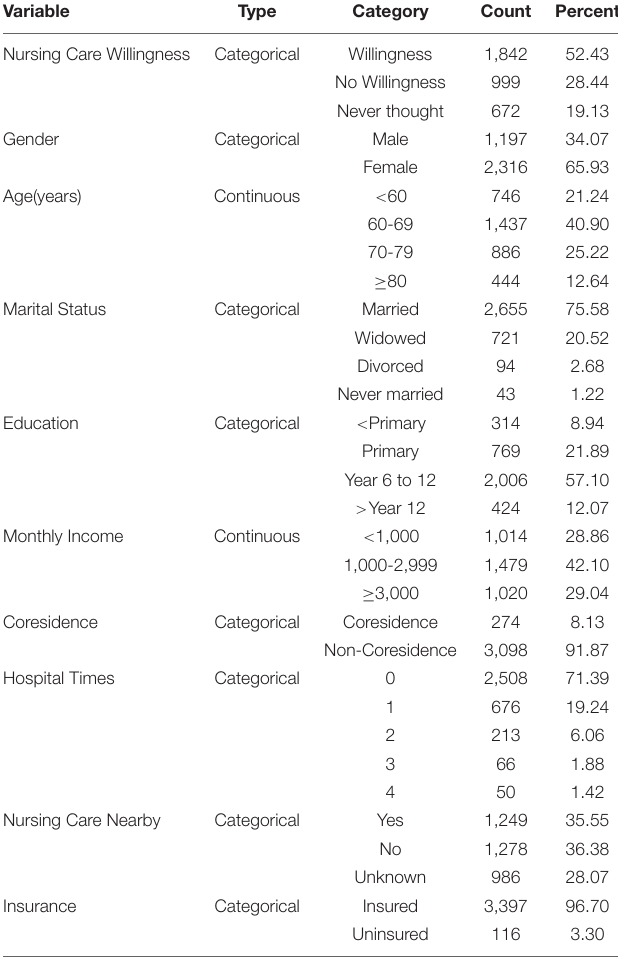
TABLE 1 | Questionnaire sample